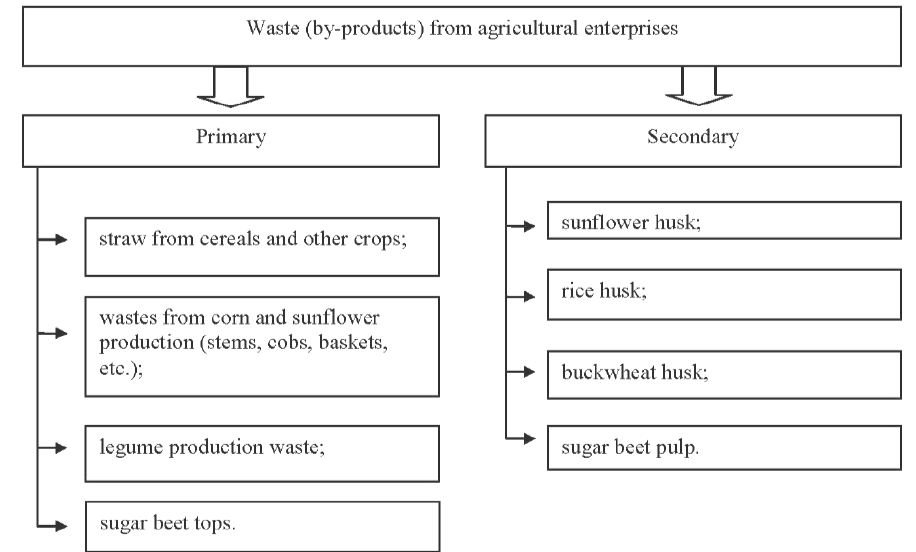
Fig. 1. The classification of waste from agricultural enterprises (Source: formed by the